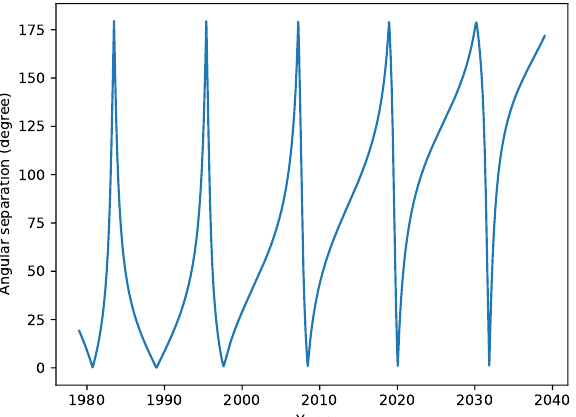
Figure 8. Temporal evolution of the angular separation between the primary jet in OJ 287 and the line joining the primary and secondary BHs. The separation is calculated assuming that the jet precession follows the disk model of Dey et al. [75]. Minimum separation angle occurs at 1980.73, 1988.95, 1997.61, 2008.45, 2020.05, and